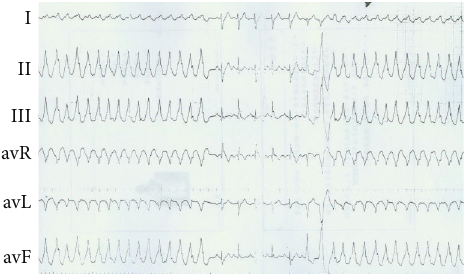
Figure 1: Body surface 12-lead ECG documented in 2005.